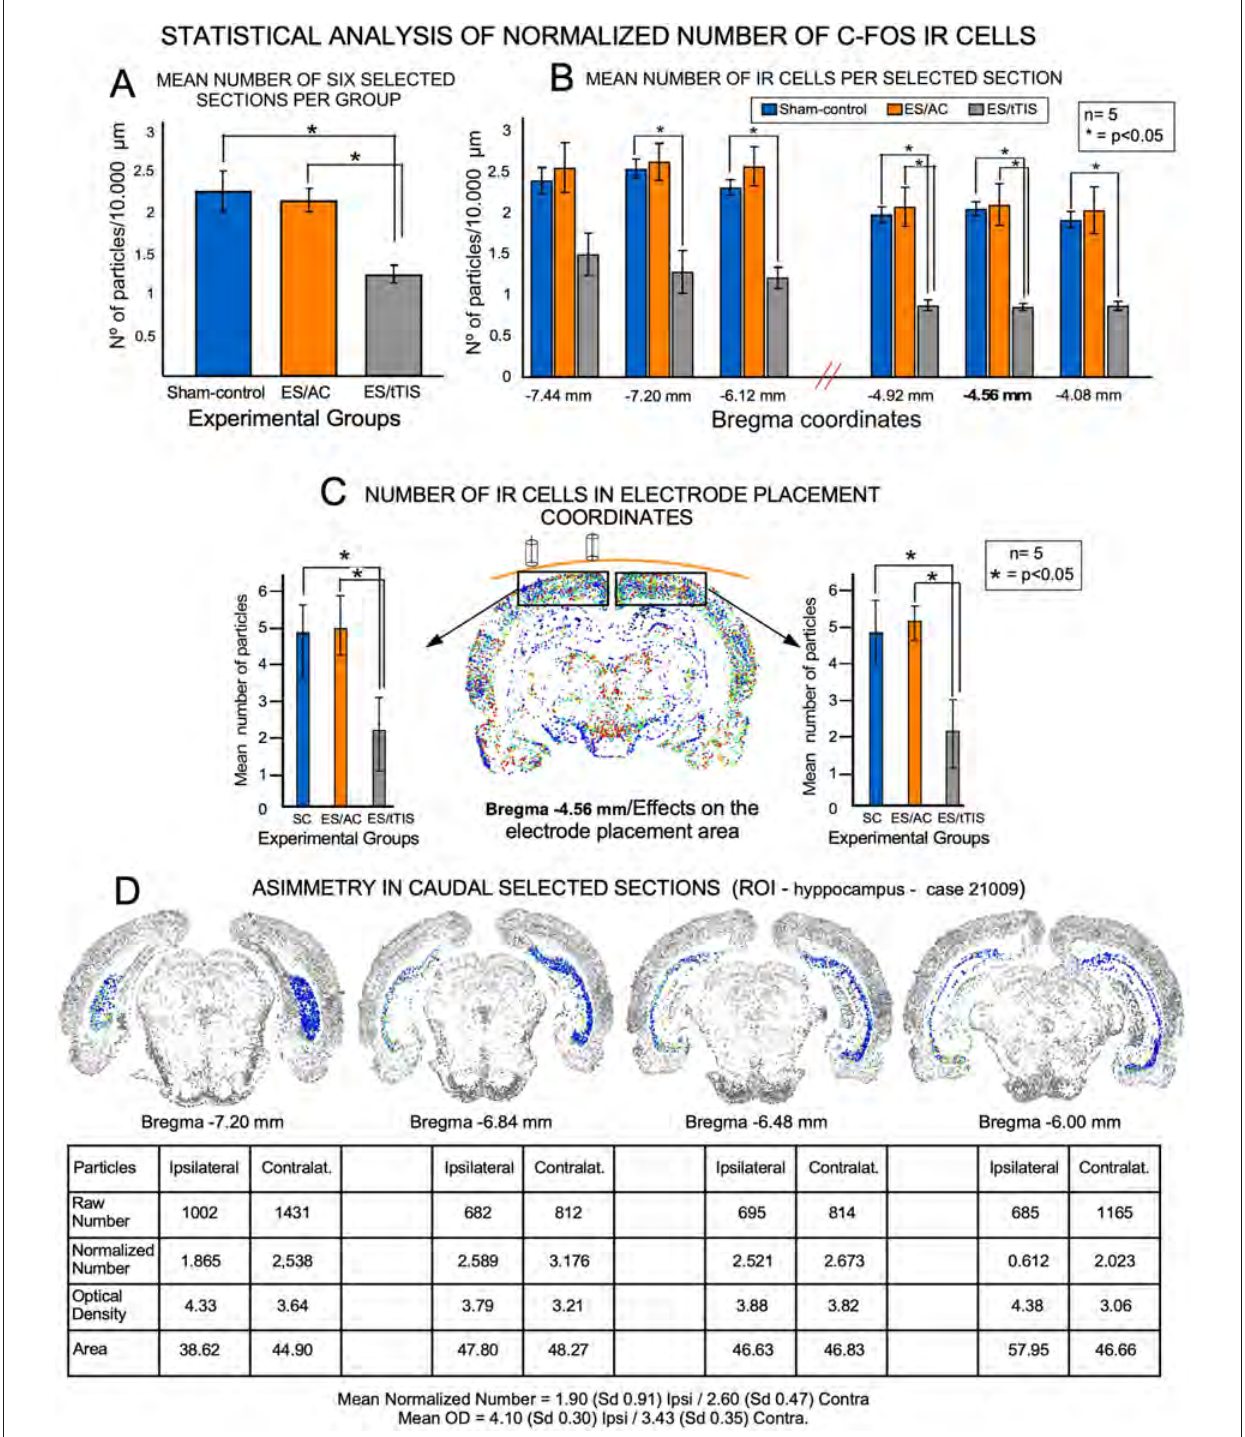
FIGURE6 Quantitative analysis of c-Fos immunostained sections. (A) Statistical analysis of normalized number of cells from six selected coronal sections per experimental group ( n = 5). (B) Statistical comparison of normalized number of neurons from six sections at equivalent coordinates in the three experimental groups. In bold in the x-axis, (Bregma -4.56 mm) points to the skull electrodes’ placement coordinates. Note that there are no significant differences between experimental groups in caudal sections (Bregma -7.44 mm), far from the electrode localization. (C) Statistical analysis of the normalized number of neurons in the dorsal area of the cortex (rectangles in the map indicate the selected ROIs) after comparing Bregma -4.56 mm sections between groups (five ROIs from left and five ROIs from the right hemisphere for each experimental group). Significant differences are observed after comparing SC (blue columns) or ES/AC (orange columns) with ES/tTIS groups (gray columns). (D) Side-by-side comparison of parameters from segmented cells (number of cells, OD, and area) in an ES/tTIS selected case. ROI in blue in the silhouettes (Subiculum). Asymmetric immunostaining is shown by numerical differences in neurons (table at the bottom of the